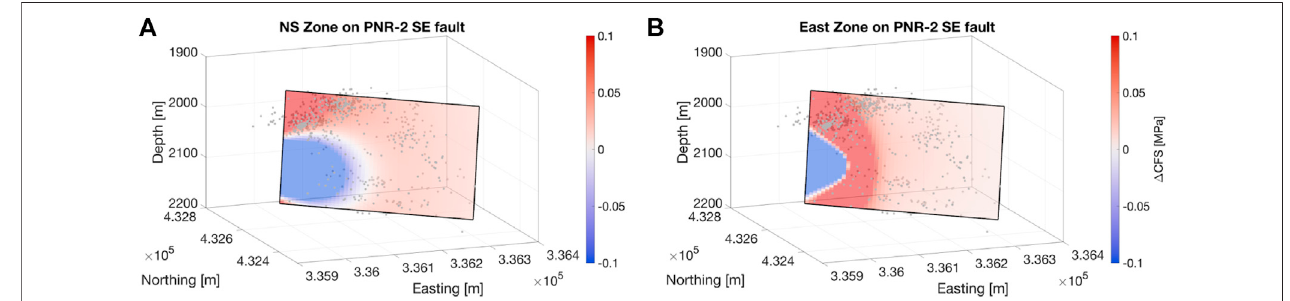
FIGURE 7 | Median Δ CFS values on the SEF fault plane (as de fi ned by the ML 2.9 event aftershocks, shown as grey dots) produced by the NS Zone (A) and the Eastern Zone (B) of model HFs. The change in the Δ CFS color scale from Figure 6 should be noted. Outside of the zone of normal stress increase immediately perpendicular to the surfaces of the fractures, Δ CFS is positive due to increases in shear stress. This will act in part to promote failure on the fault ’ s surface.